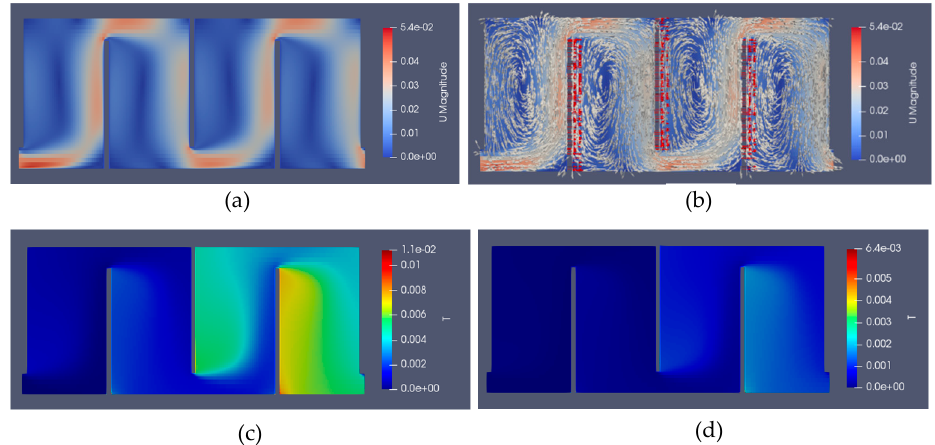
Figure 6. Velocity magnitude and concentration distributions in the contact tank for the classic design (without slot baffle case): ( a ) Flow distribution; ( b ) Flow distribution with velocity vectors; ( c ) Concentration distribution at 200 s; ( d ) Concentration distribution at 300 s.